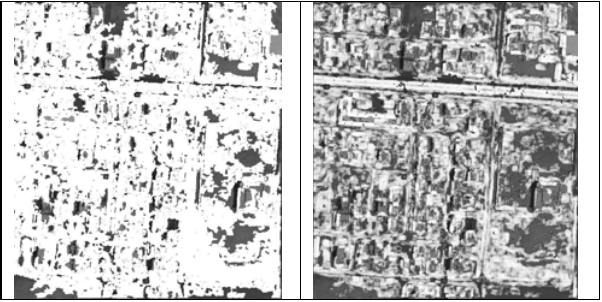
Figure 5: Aerial image 63cm GSD: left: white = areas with points matched by LSM, right: quality image – grey value of matched points corresponding to correlation coefficient of LSM; grey value = 255 corresponding to r=1.0, grey value 50 to r=0.6